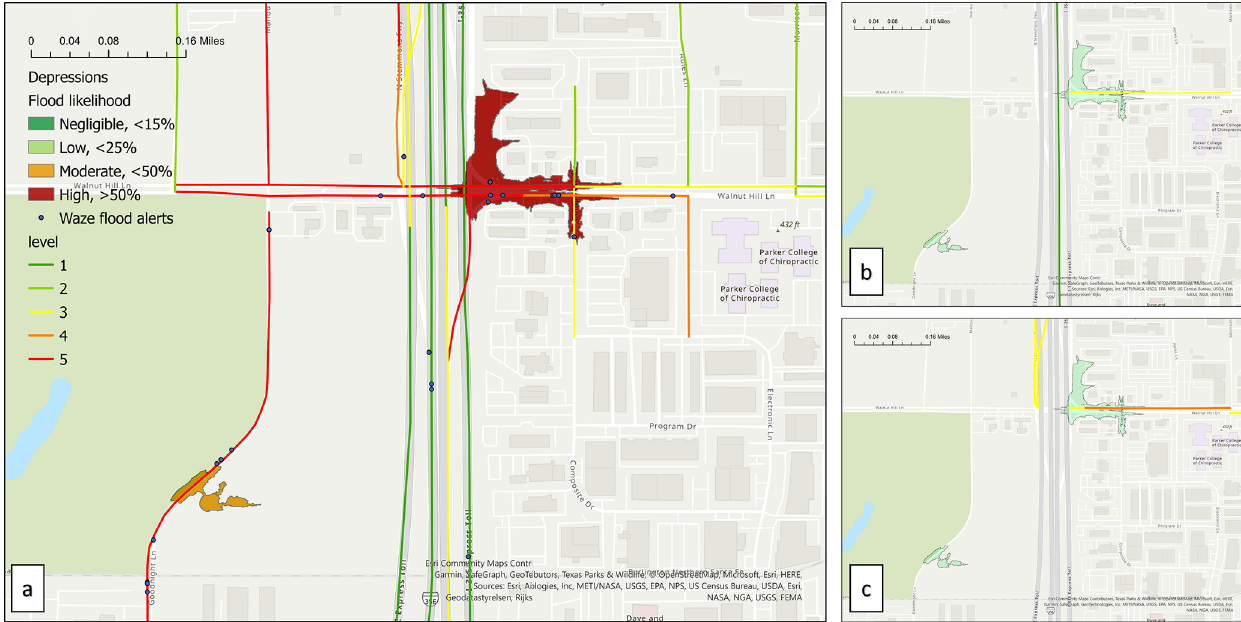
Figure 15. PFF probability map versus flood alerts and traffic jams from 13:00 to 17:00CST on (a) Friday, 22 September with a severe storm; (b) Friday, 29 September 2018, rainless; and (c) Friday, 15 September 2018,